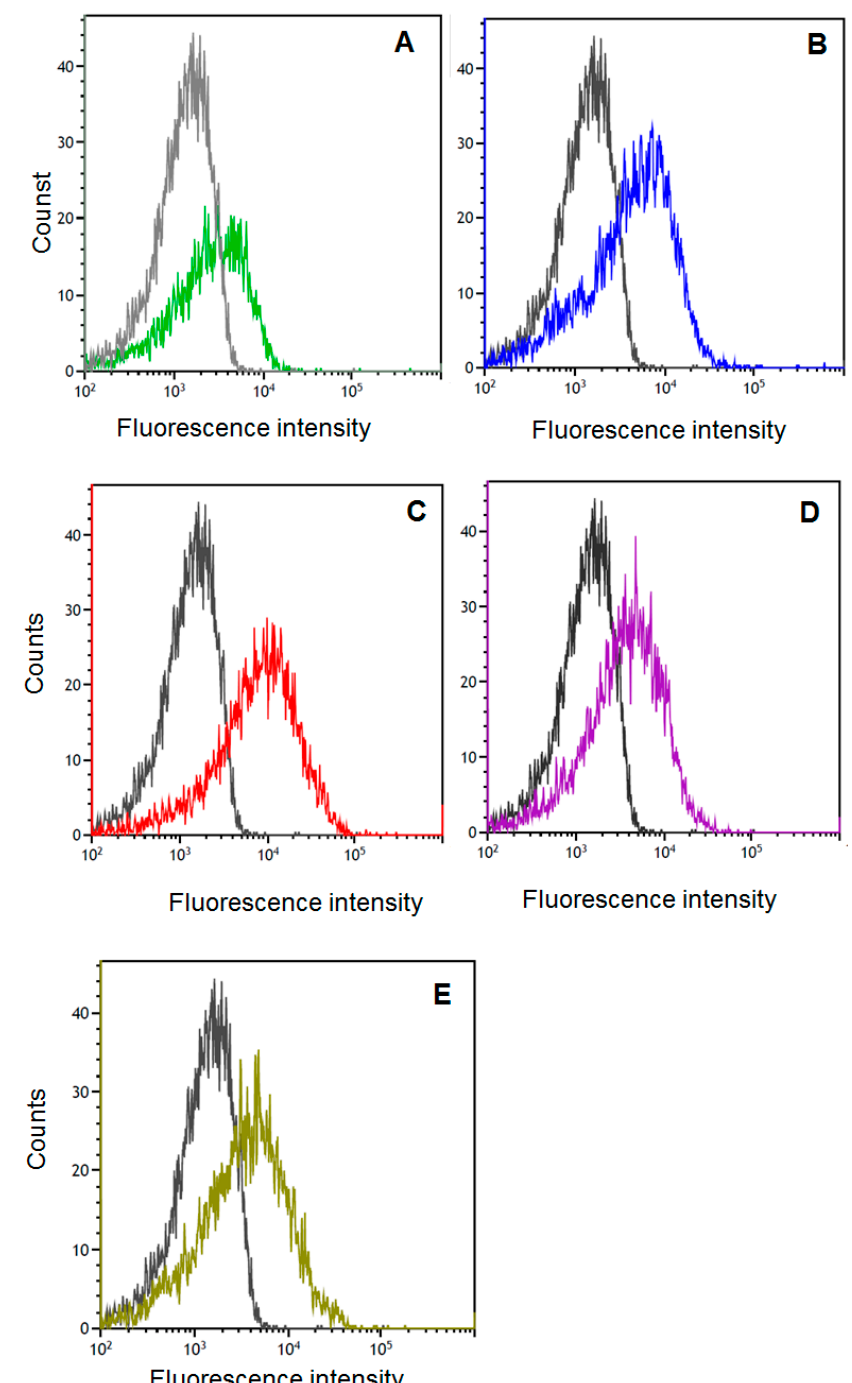
Figure 4. Analysis of surface localization of LysM-LacLMLreu and LysM-LacZLbul in Lactobacillus cells by using flow cytometry: surface anchored-LysM-LacLMLreu in L. plantarum WCFS1 ( A , green line); surface anchored-LysM-LacZLbul in L. plantarum WCFS1 ( B , blue line), in L. delbrueckii subsp. bulgaricus DSM 20081 ( C , red line), in L. casei ( D , purple line) and in L. helveticus DSM 20075 ( E , olive line). Non-displaying Lactobacillus cells were used as negative controls (A–E, black line).